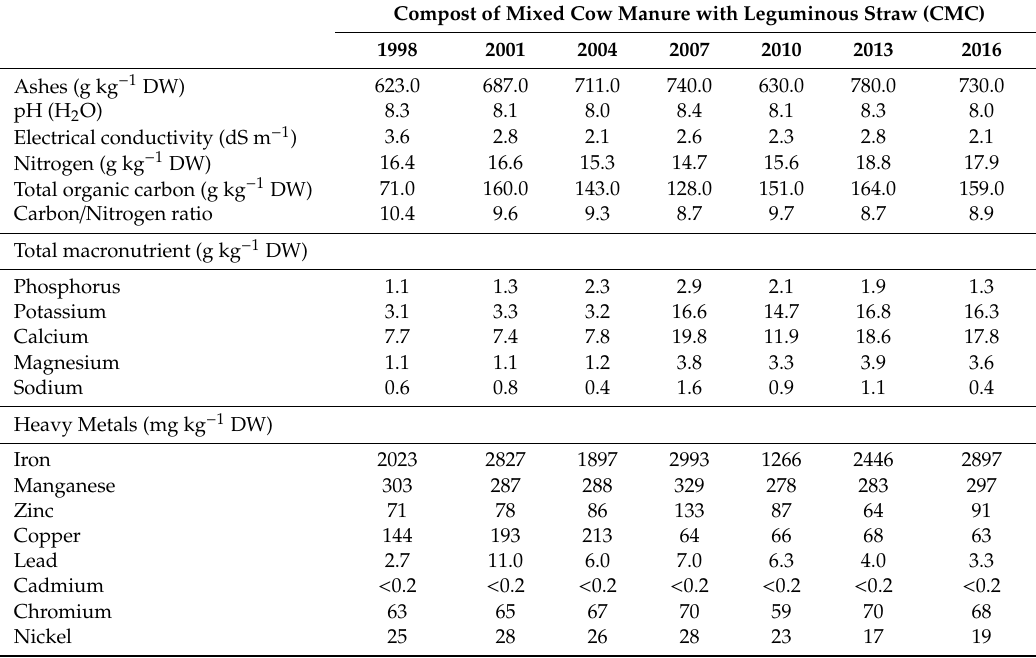
Table 4. Main analytical characteristics of the compost obtained from the mixture of cow manure with leguminous straw (CMC) and applied to the soil in the years of study.